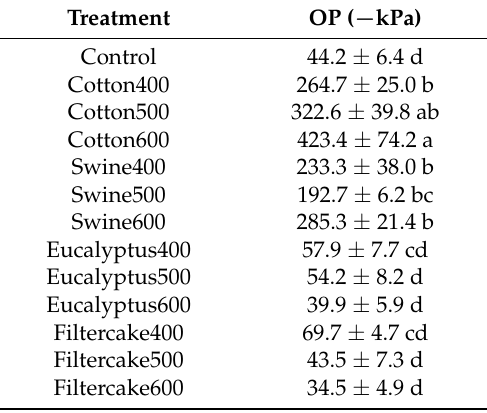
Figure 3. ( a ) Mean volumetric water content ( θ ; %) and ( b ) electrical conductivity (EC; dS m − 1 ) over 6 weeks ( n = 5). Capital letters represent significant differences between the feedstocks while lowercase letters represent significant differences between the temperatures (Tukey test; p < 0.05). Table 1. Soil osmotic potential (OP) from each treatment. Lowercase letters indicate significant differences between the treatments ( n = 4, Tukey test, p <